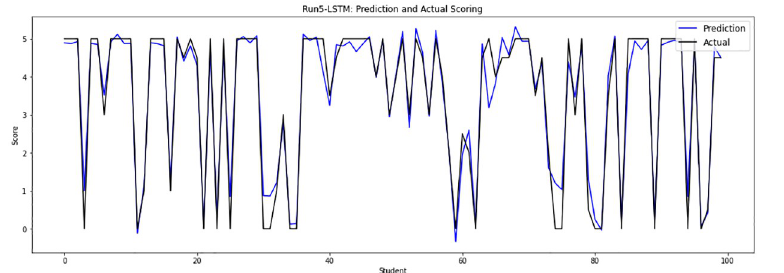
Fig 10. LSTM-GWO prediction and actual scores with experiment